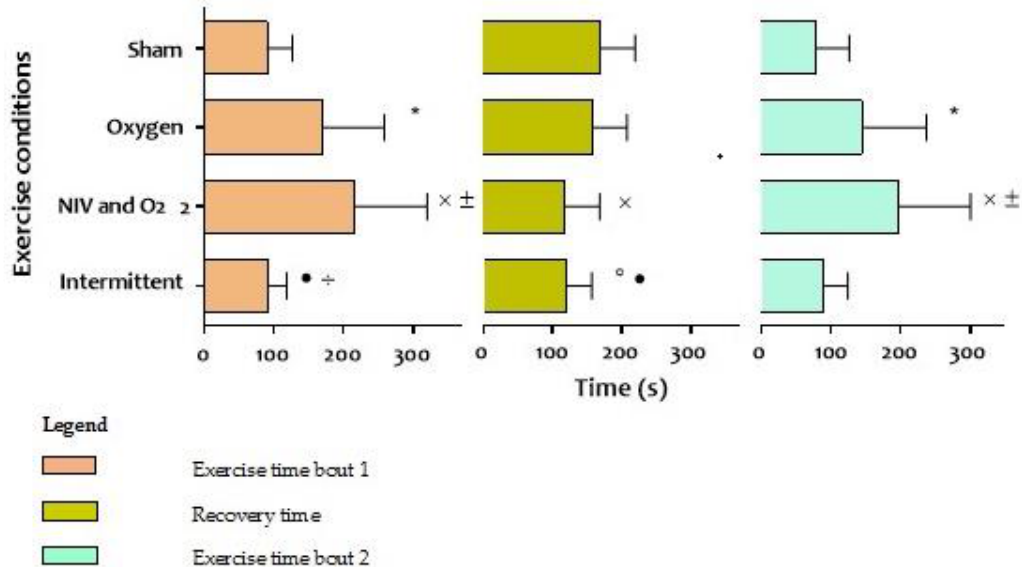
Figure 3. Results of walking time bout 1 and 2 and time till recovery in four tests with di ff erent ventilator settings. Statistical significant di ff erences ( p < 0,05); * = sham vs. oxygen, × = sham vs. NIV and O 2 , ◦ = sham vs. intermittent, ± = oxygen vs. NIV and O 2 , • = oxygen vs. intermittent, ÷ = NIV and O 2 vs. intermittent; Abbreviations: NIV = non-invasive ventilation, O 2 = oxygen, s = seconds.